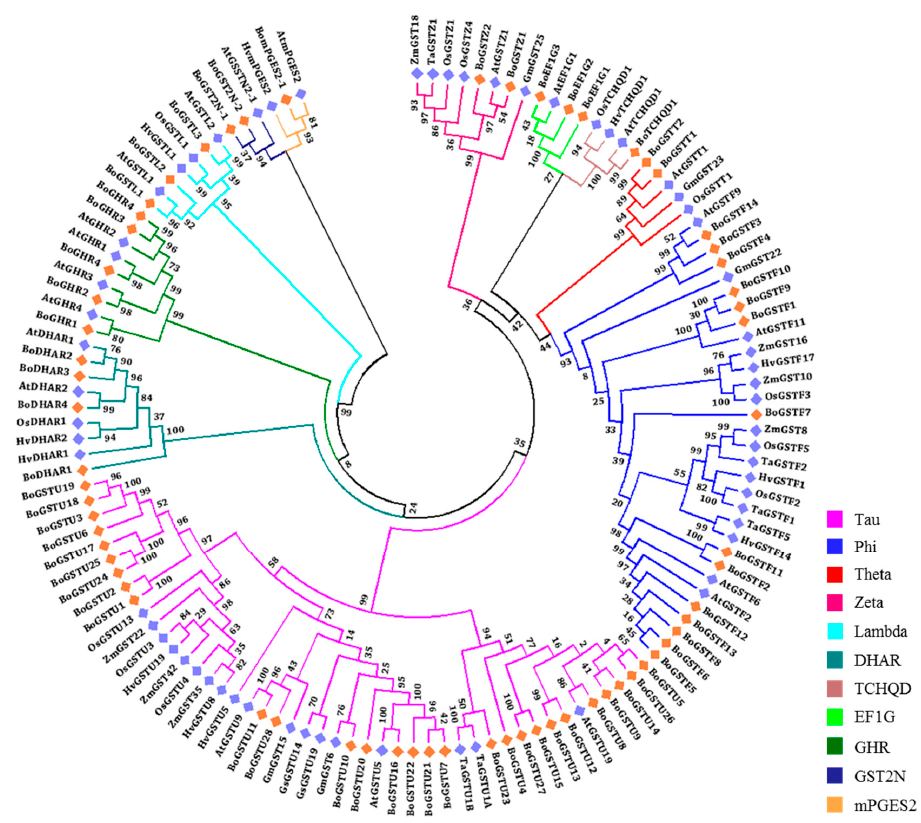
Figure 1. Phylogenetic trees and classification of glutathione transferase (GST) proteins of B. oleracea using Arabidopsis , rice, barley, wheat, sorghum, maize, and soybean published GST proteins. The unrooted phylogenetic trees was constructed based on multiple sequence alignment using ClustalW followed by maximum-likelihood method using JTT model MEGA6.06 software. Highlighted genes with diamond symbol, orange color represents BoGSTs and blue color represents orthologous GST genes.